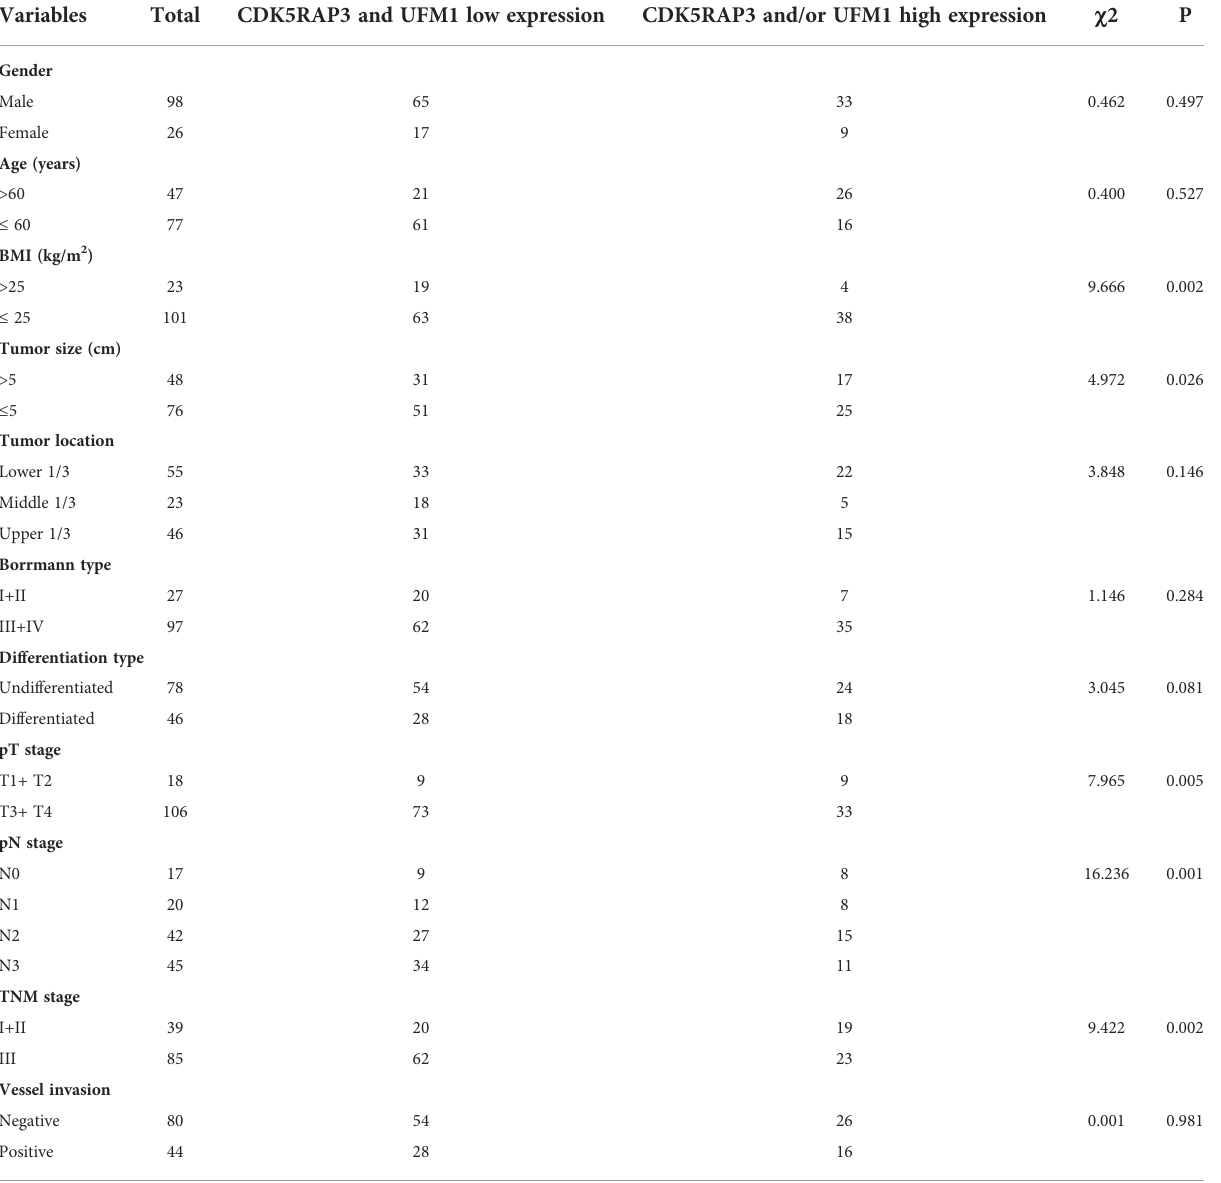
TABLE 2 The association of different CDK5RAP3 and UFM1 expression levels in gastric cancer tissues with clinicopathological factors.